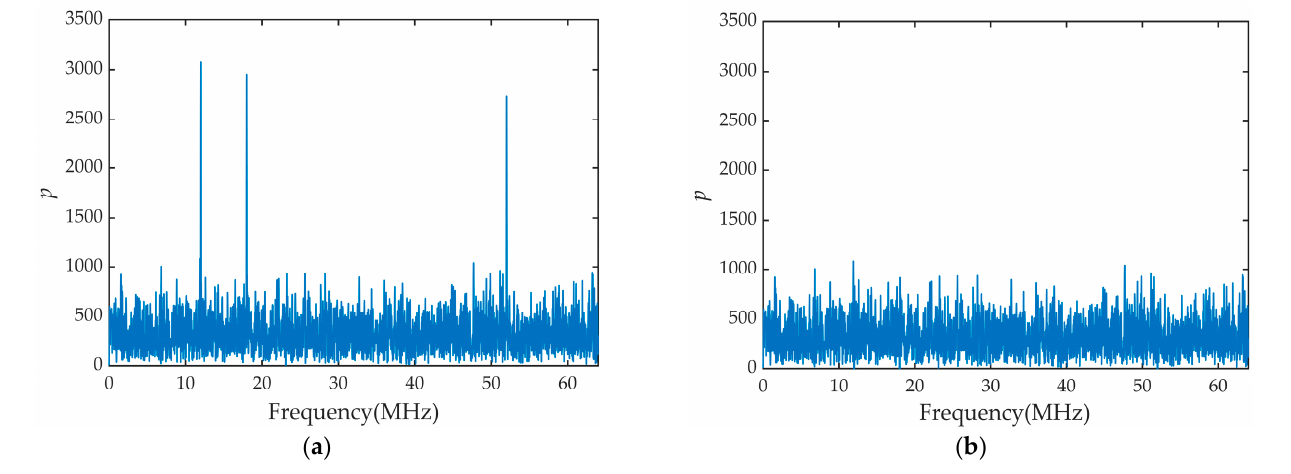
Figure 3. Spectrum of the signal. ( a ) The obtained spectrum refers to the case of the received signal when SNR = 30 dB. ( b ) The spectrum of the noise signal.